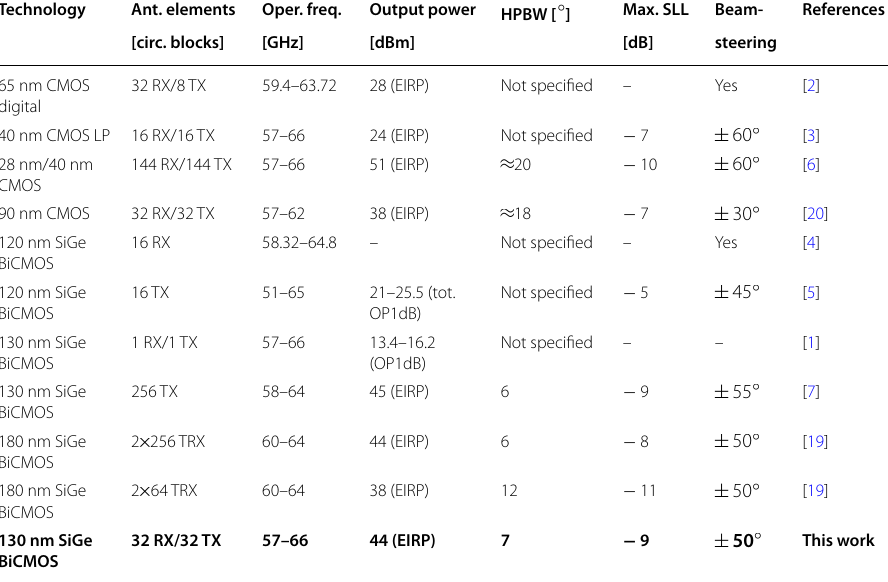
Table 1 Performance comparison with state-of-the-art solutions Technology Ant.